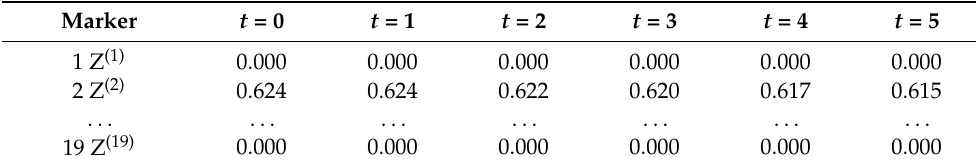
Table 14. Reconstructed series of Z coordinates of markers based on the signal components.